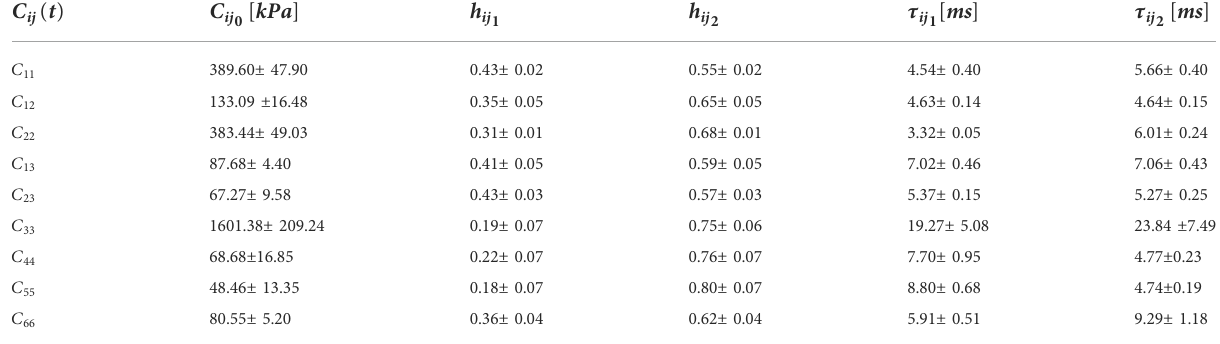
TABLE 3 Prony series coef fi cients for all C ij ( t )